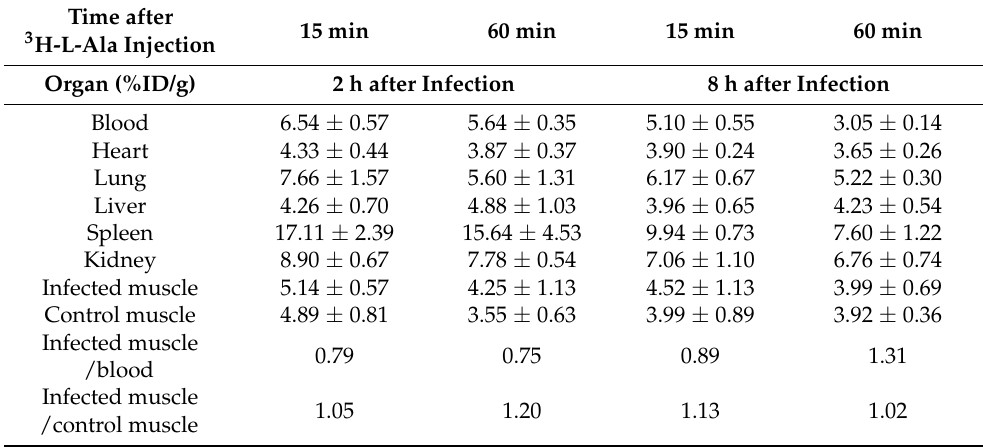
Table 1. Biological distribution of 3 H-L-Ala in EC-14 infection model mice. Time after 3 H-L-Ala Injection 15